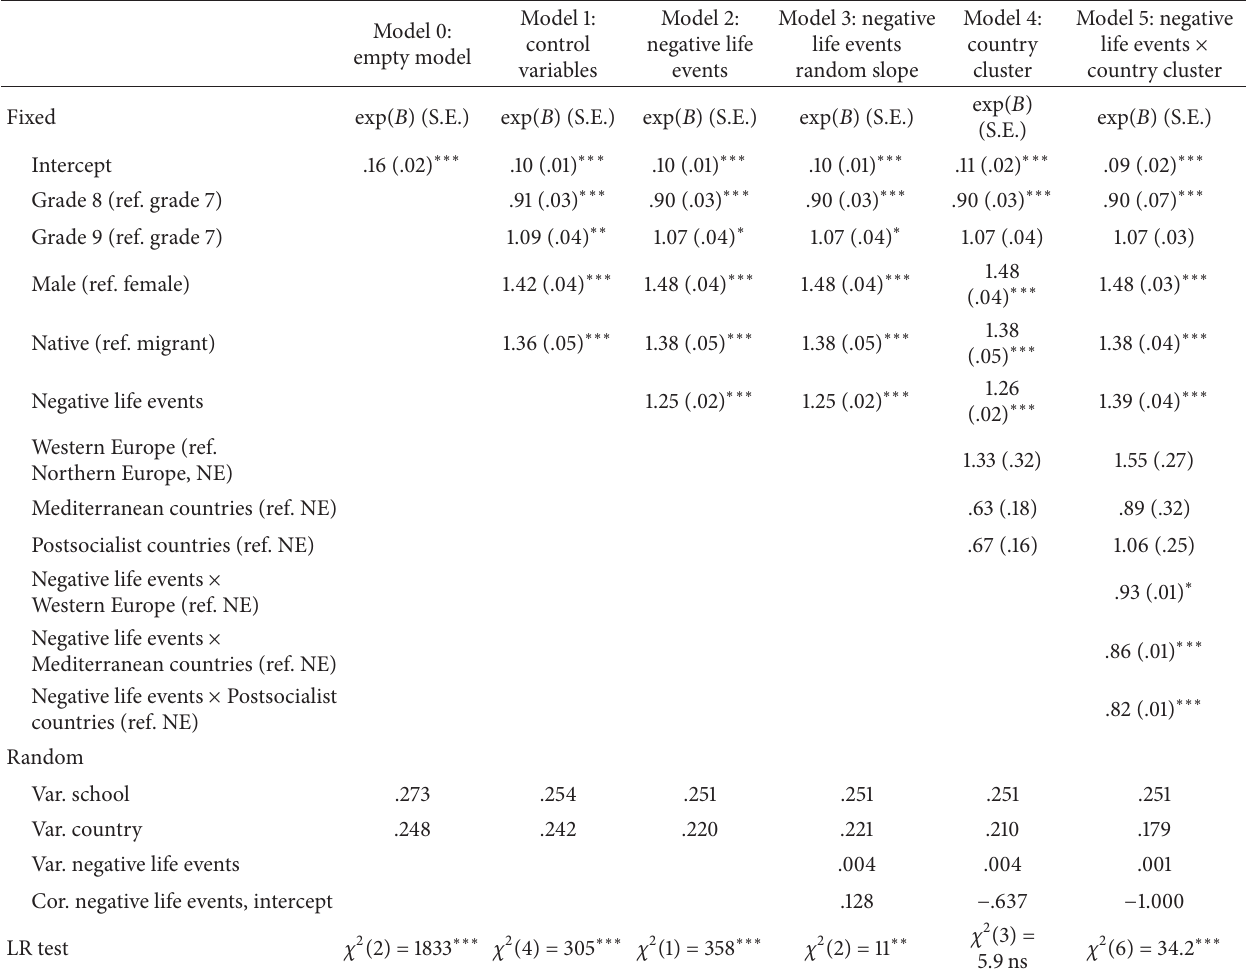
Table 7: The results of multilevel analysis concerning negative life events ( 𝑛 individuals: 52386; 𝑛 schools: 1344; 𝑛 countries: